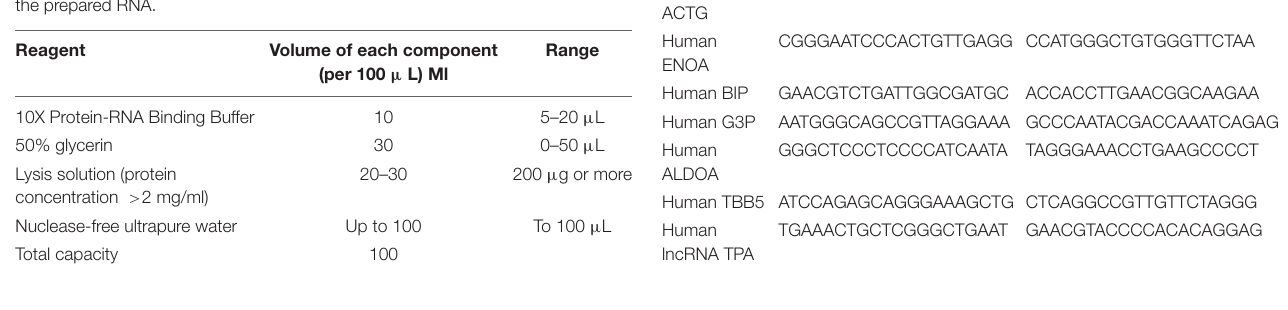
TABLE 1 | The main components of the protein binding reaction of the prepared